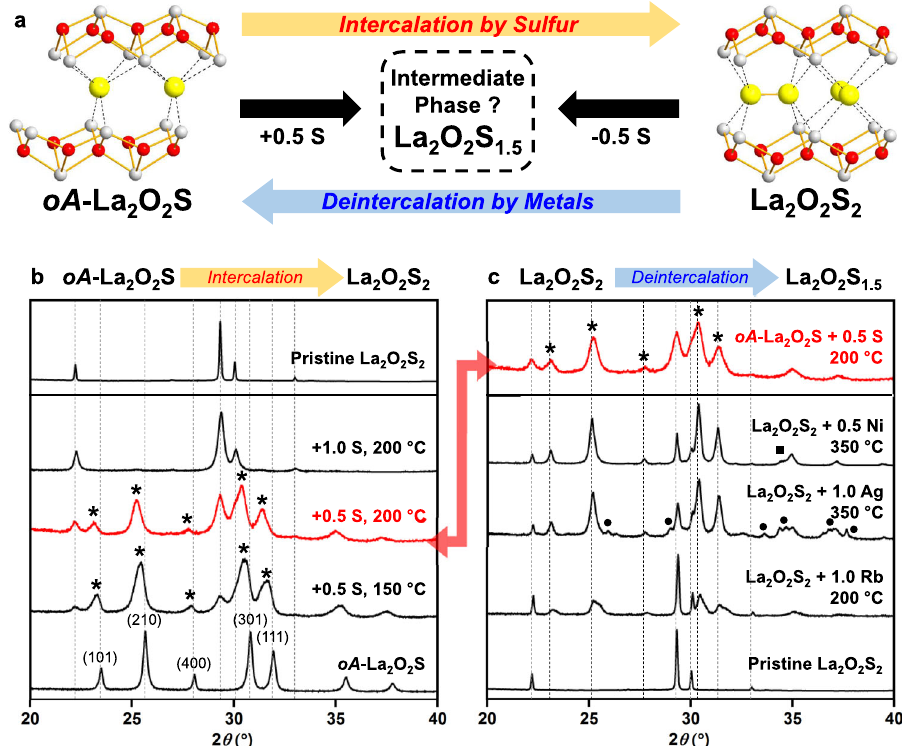
Fig. 3 Incomplete intercalation and deintercalation of sulfur. a Schematic representation of incomplete intercalation of sulfur into oA -La 2 O 2 S and deintercalation of sulfur from La 2 O 2 S 2 that leads to an intermediate compound La 2 O 2 S 1.5 . b Intercalation experiments of sulfur into oA -La 2 O 2 S. Experimental XRD patterns of pure oA -La 2 O 2 S and of the products of its mixture with sulfur (0.5 or 1 equiv. of S) after thermal treatments at 150 or 200 °C. The new XRD peaks emerging after the thermal treatment with 0.5 S are marked by *. c Deintercalation of sulfur from La 2 O 2 S 2 . Experimental XRD patterns of La 2 O 2 S 2 and of the product of its mixture with Rb 0 , Ag 0 , and Ni 0 after the thermal treatments at 200 or 350 °C. The XRD peaks of minor by-products are marked as follows: ● = Ag 2 S 37 , ■ = α -NiS 38 .